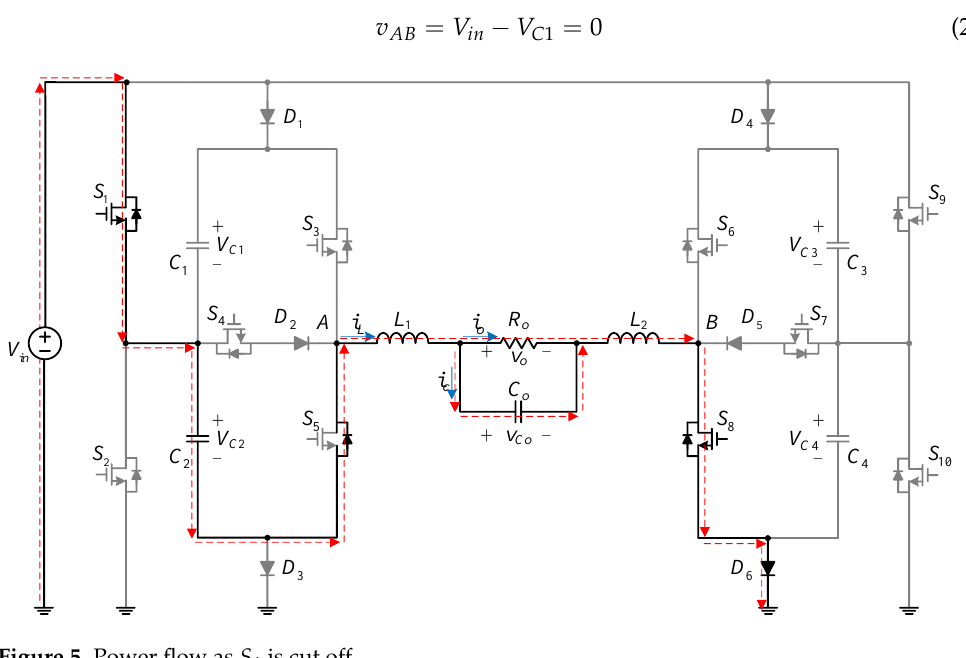
Figure 5. Power flow as S 4 is cut off.